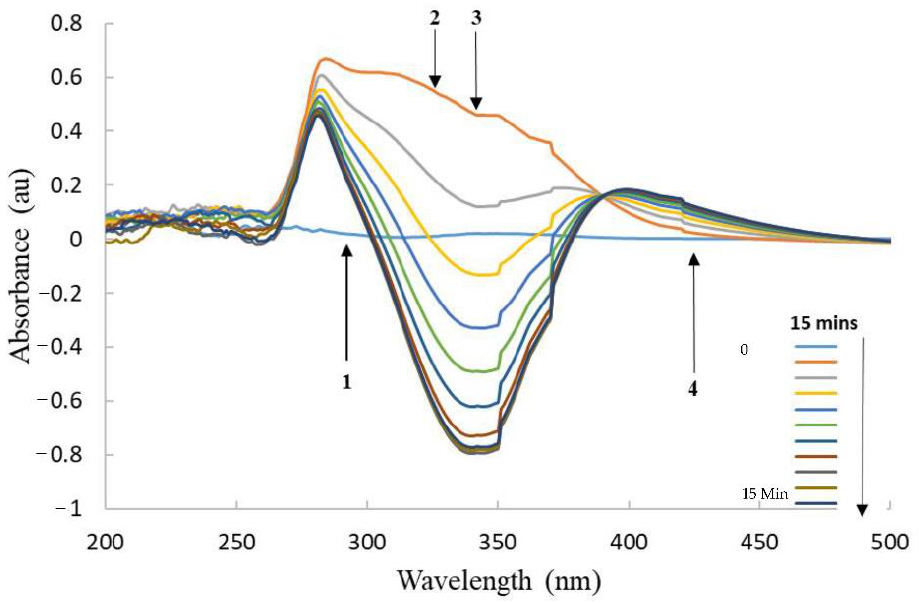
Figure 6. UV-Vis spectra of AuMNP immobilised YfkO-cys showing the enzymatic activity assay with increasing time. (1) NTR absorbance ~290 nm. (2) Reduction of CB1954 λ-max = 327 nm. (3) Oxidation of NADH λ-max = 340 nm. (4) Production of CB1954 hydroxylamine derivatives λ-max = 420 nm.